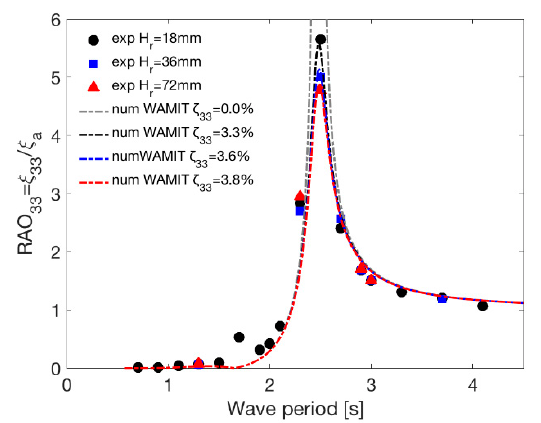
Figure 12. RAO heave motion result comparisons between the experiment and WAMIT numerical calculations for different external damping levels.